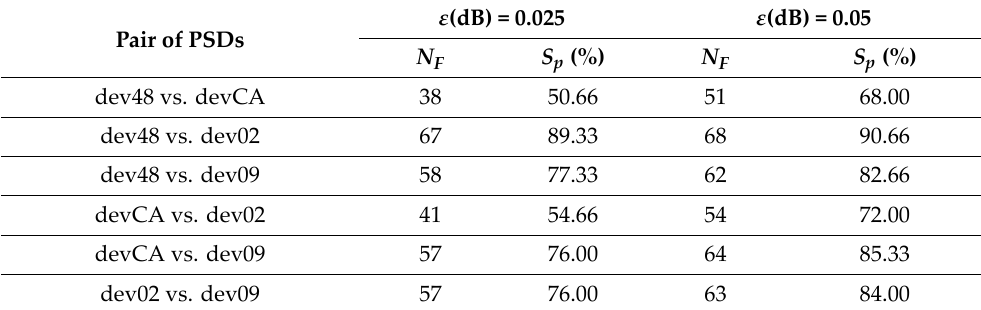
Table 6. Results of the comparison of the average PSDs of four devices transmitting the same data.